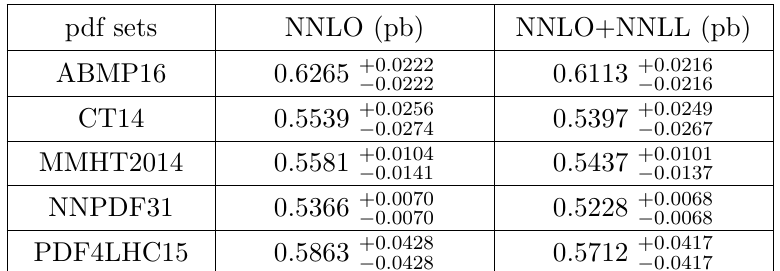
Table 1 . Resummed cross-sections are provided for 13 TeV LHC using NNLO pdf set for di(cid:11)erent pdf groups for central scale choice ( (cid:22) c respective pdfs through LHAPDF interface at